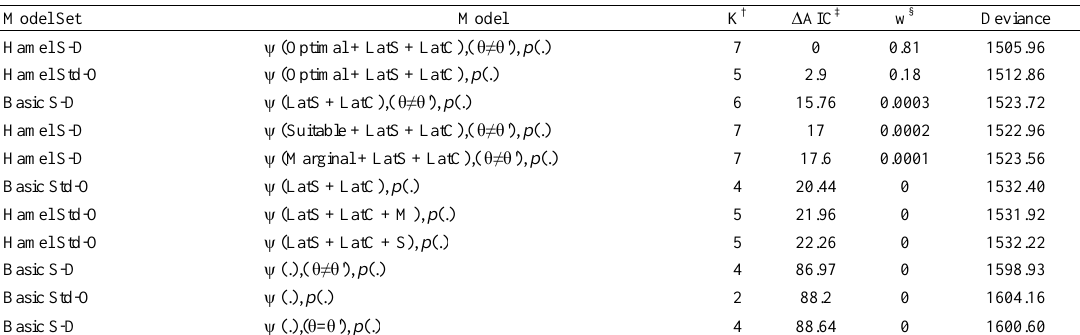
Table 5. Model selection results for Red-headed Woodpecker ( Melanerpes erythrocephalus ) occupancy models in the South Atlantic Coastal Plain, United States, 2001. Occupancy ( ψ ) was modeled as constant (.), as a function of latitude (LatS = 29-31°, LatC = 32-34° N, LatN = 35-37° N) and Hamel’s habitat suitability categories, namely, optimal (O), suitable (S), and marginal (M). Optimal habitat was modeled as defined by Hamel (1992) and as Optimal-revised to reflect recent literature on the species (see text). Detection probability ( p ) was modeled as constant (.). Models account for spatial correlation within segment stations ( θ = θ ` or θ ≠ θ `). The term Basic Model means that occupancy ( ψ ) was not constrained by a covariate, or constrained by latitude. S-D means spatial dependence model structure; Std-O means standard occupancy model structure. LatN defaults to the intercept in model parameterizations when modeled with LatS and LatC. In the final model parameterization, which featured one latitude category at a time, LatS and LatC default to the intercept. Model assumptions for the standard occupancy model were met